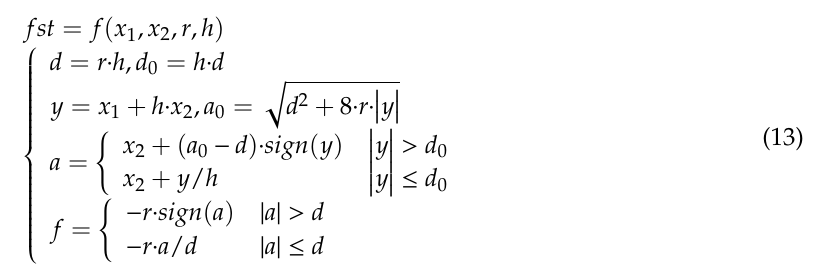
Figure 11. The structure of the longitudinal control.